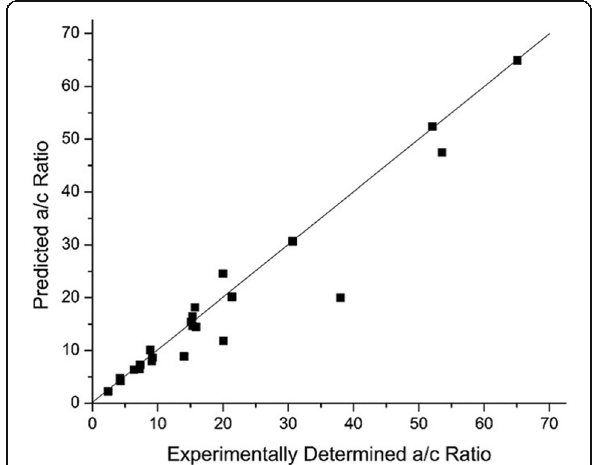
Fig. 4 Predicted versus experimental amorphous-to-crystalline solubility (a/c) ratios (Adapted from (Taylor and Zhang